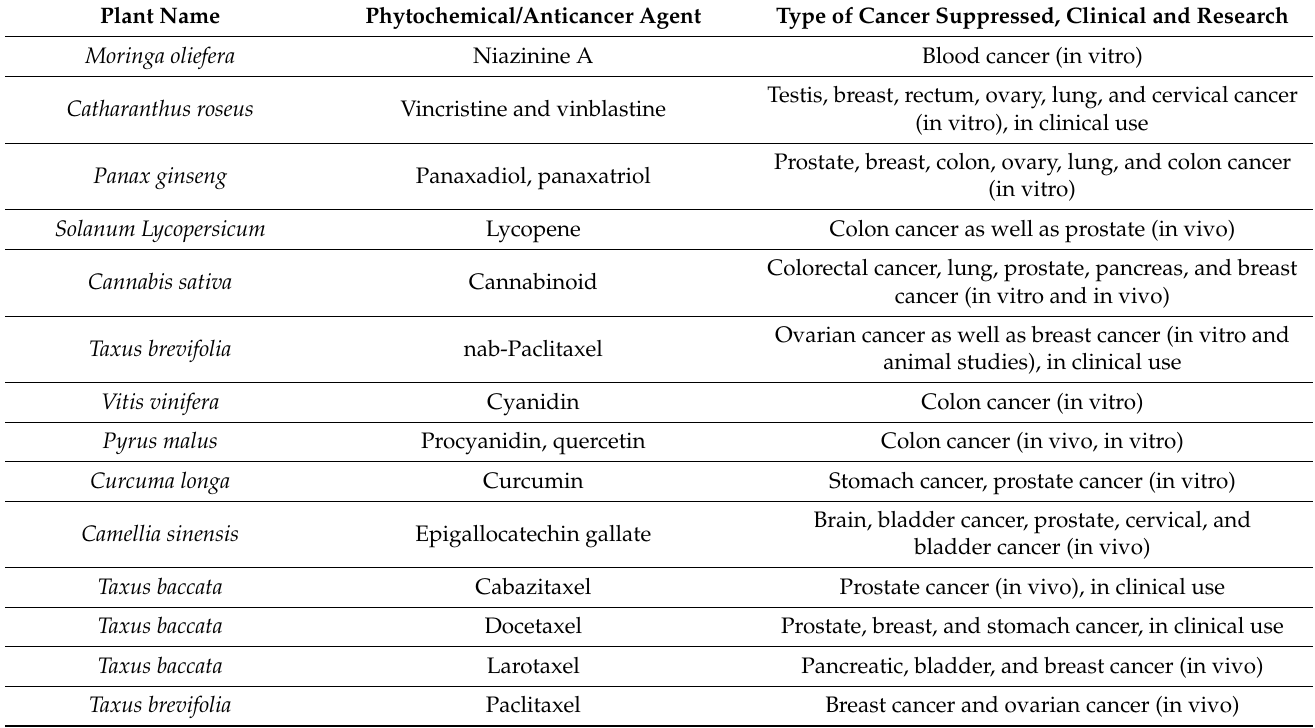
Table 8. Summary of various medicinal plants used against different types of cancers